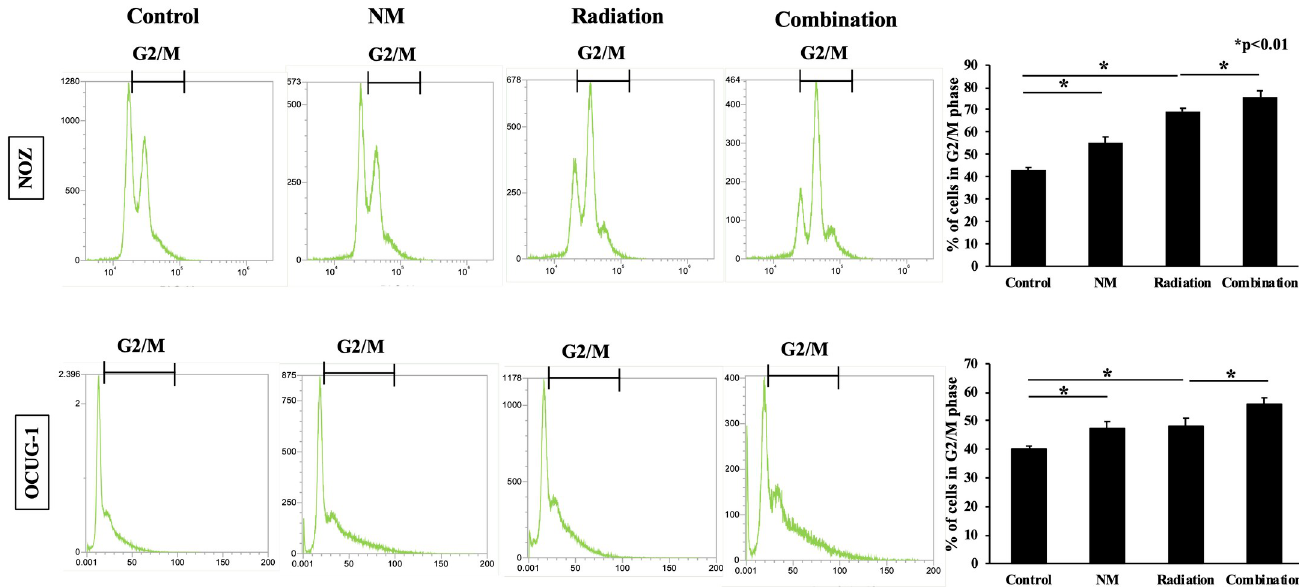
Fig 4. NM enhanced radiation-induced G2/M phase cell cycle arrest. Cell cycle analysis by flow cytometry revealed that the proportion of cells in G2/M phase in the combination group was higher than that in the radiation group for NOZ and OCUG-1 cells (NOZ: 75.8 ± 2.75% vs. 69.3 ± 1.5%, p < 0.01; OCUG-1: 55.9 ± 2.2% vs. 48.1 ± 2.8%, p < 0.01).